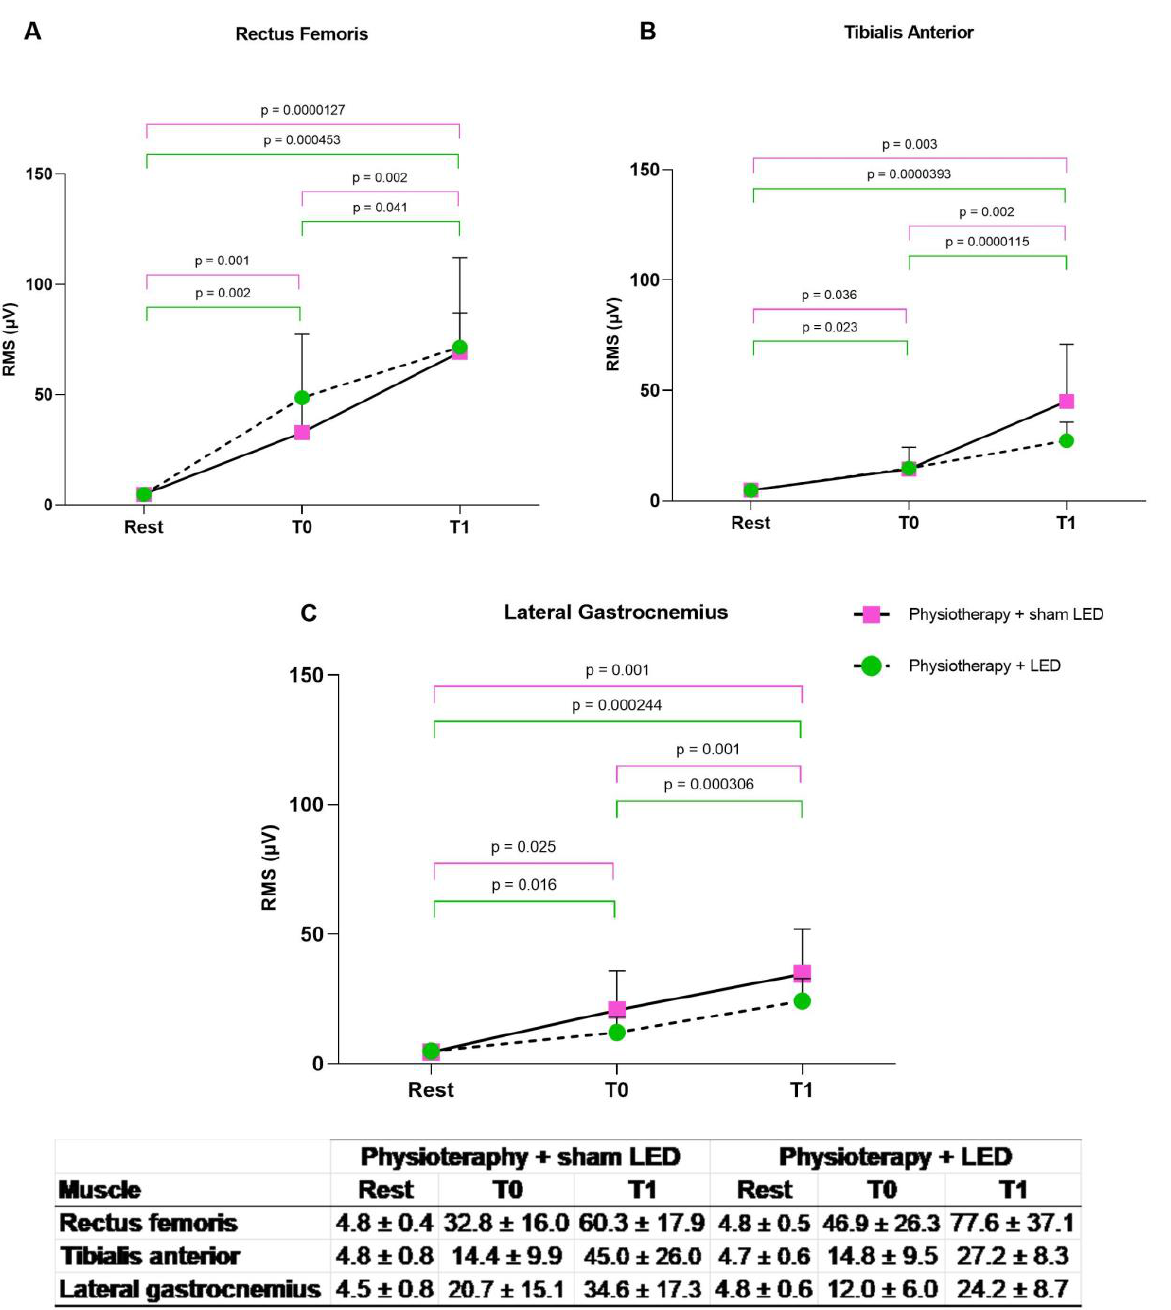
Figure 6. ( A – C ) RMS values of less compromised lower limb. Improvements in electrical muscle activity found in both treatment groups. T0 = pre-intervention; T1 = after 24 sessions; STS = sit-to- stand